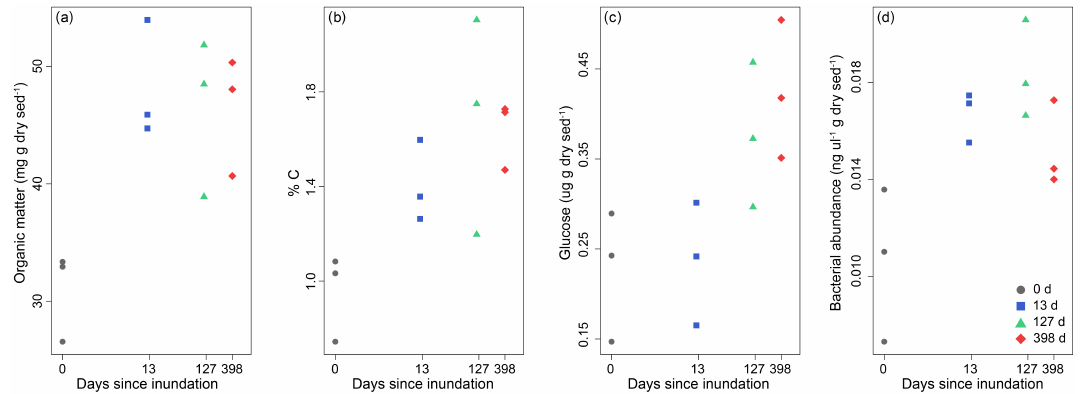
Figure 2. Environmental/microbial variables with a stepped relationship to days since inundation. All have significant categorical differences (ANOVA; P < 0 . 05 for all). Note that the x axis is plotted as a log